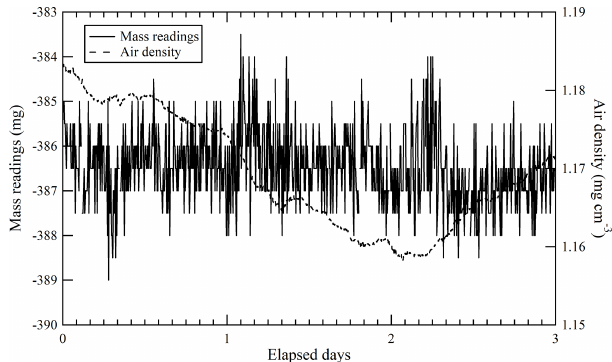
Figure 4. Repeatability of mass readings obtained for the sample cylinders and ambient air density for 3d. Solid and dashed lines represent mass readings and ambient air density,